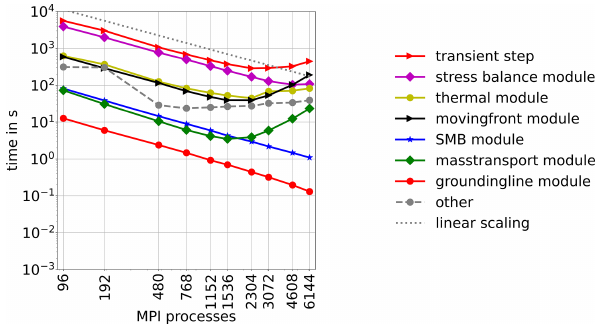
Figure 3. Runtime of a transient time step of ISSM without output handling in resolution